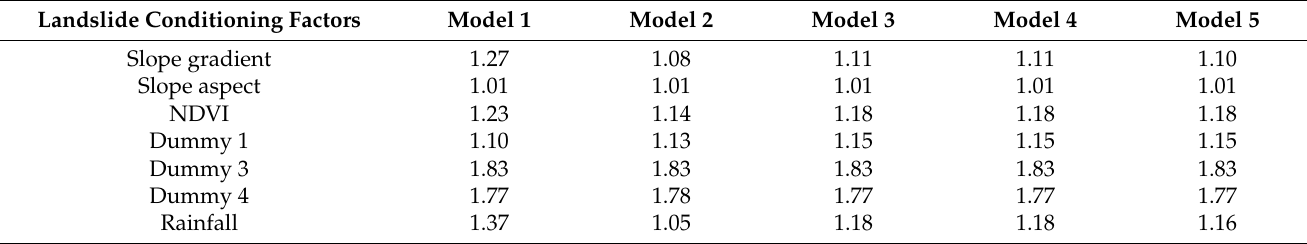
Table A4. Variance inflation factors (VIF) for the five models (i.e., models 1–5).